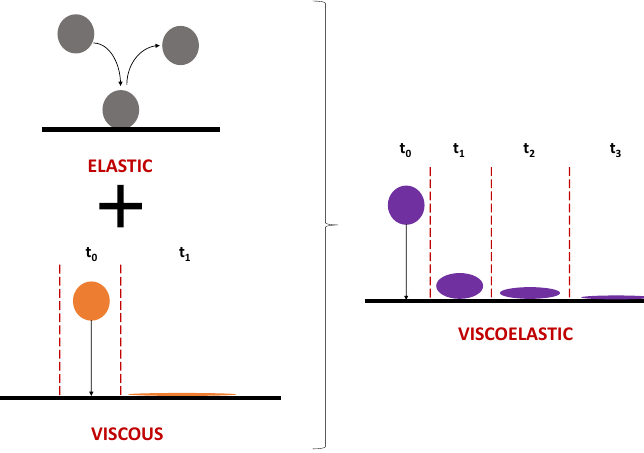
Figure 4. Illustration of elastic, viscous and viscoelastic behavior .